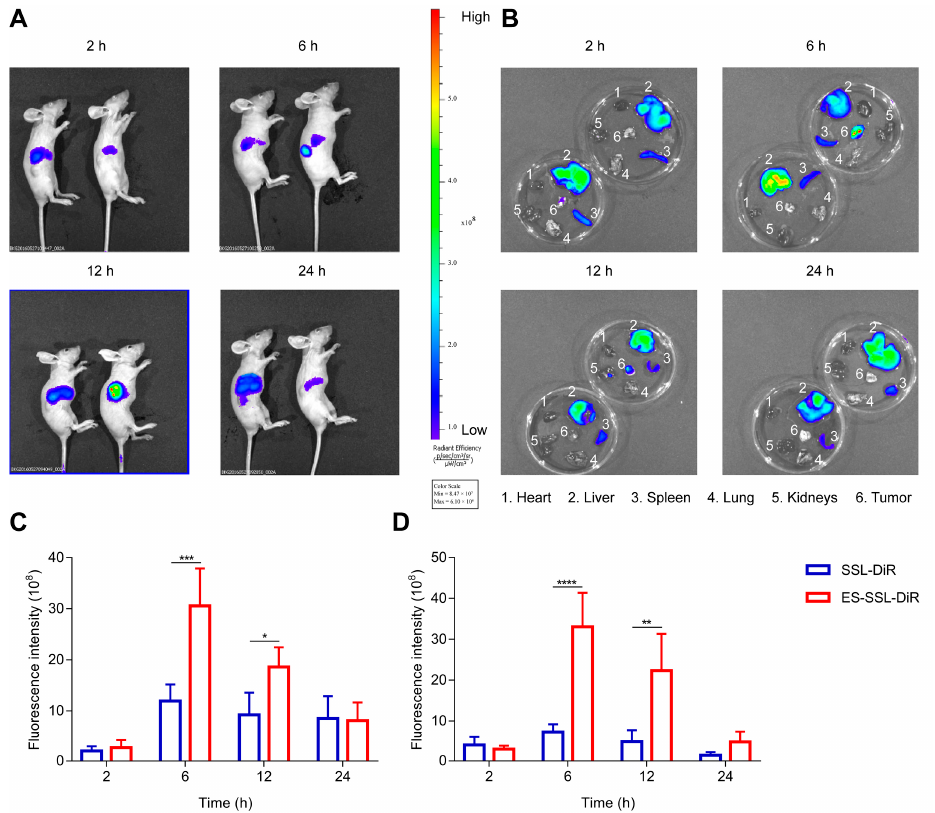
Figure 8. In vivo tumor-targeting study. ( A ) Fluorescence photograph of mice injected with SSL-DiR and ES-SSL-DiR in vivo (left: SSL-DiR group, right: ES-SSL-DiR group). ( B ) Fluorescence photograph of the ex vivo main organs and tumor from mice injected with DiR liposomes (left: SSL-DiR group, right: ES-SSL-DiR group). ( C ) Fluorescence intensity at tumor site in vivo, * p < 0.05, *** p < 0.001. ( D ) Fluorescence intensity of the ex vivo tumor, ** p < 0.005, **** p < 0.0001.